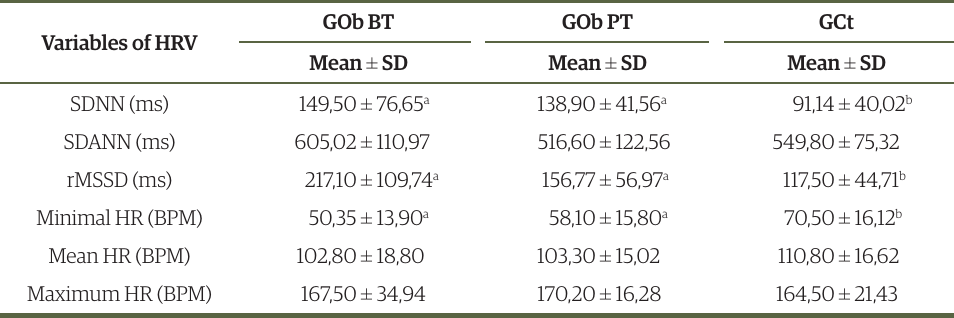
Table 1. HRV: Heart Rate Variability; SDNN: Standard deviation of all RR intervals; SDANN: Standard deviation of the mean NN intervals obtained every 5 minutes; rMSSD: Square root of the mean between the squared differences of the consecutive NN intervals; GOb BT: Obese Group Before Treatment; Gob PT: Obese Group Post-Treatment of 6 months; GCt: Control Group; HR: Heart Rate; SD: Standard Deviation; ms: milliseconds; BPM: beats per minute. Different letters (“a” and “b”) along the same line indicate a significant difference at level of